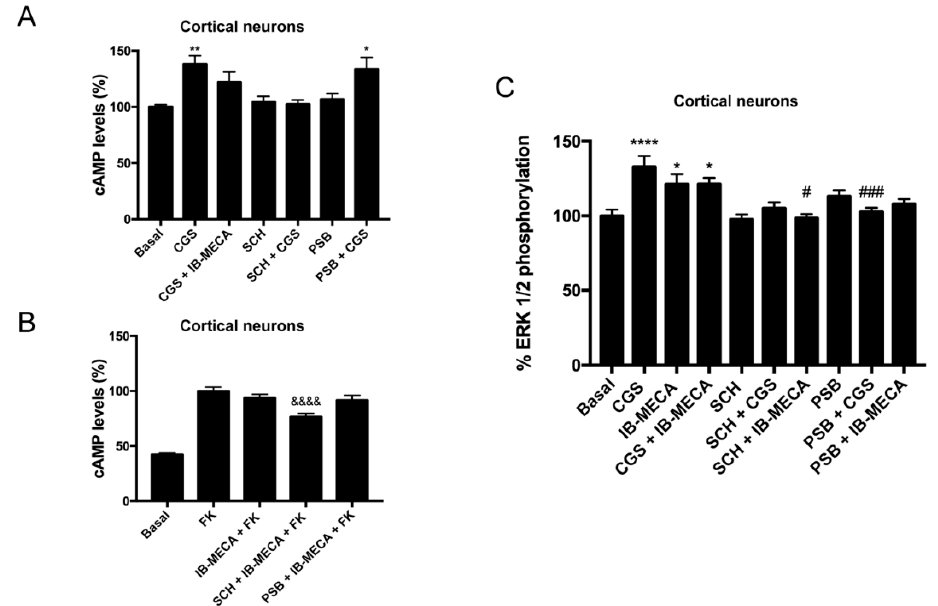
Figure 4. cAMP determination and ERK1/2 phosphorylation assays in primary cultures of cortical neurons. Panels A–B : neurons cultured for 14 days were stimulated with selective receptor antagonists (1 µM SCH 442416 for A 2A R or 1 µM PSB-10 for A 3 R) and subsequently with selective agonists (100 nM CGS 21680 for A 2A R and 100 nM IB-MECA for A 3 R), then intracellular cAMP concentration was determined. In panel B, experiments were performed in cells finally treated with 500 nM forskolin. Values are the mean ± S.E.M. (n = 6 in triplicates). Panel C : neurons cultured for 14 days were stimulated with selective antagonists for 10 min and subsequently with selective agonists for 7 min, then ERK1/2 phosphorylation was determined. Values are the mean ± S.E.M. (n = 6 in triplicates). One-way ANOVA followed by Bonferroni’s multiple comparison post hoc test were used for significance analysis. * p < 0.05, ** p < 0.01, and **** p < 0.0001 versus vehicle treatment (basal); # p < 0.05, ### p < 0.001 versus agonist treatment. &&&& p < 0.0001 versus forskolin treatment.